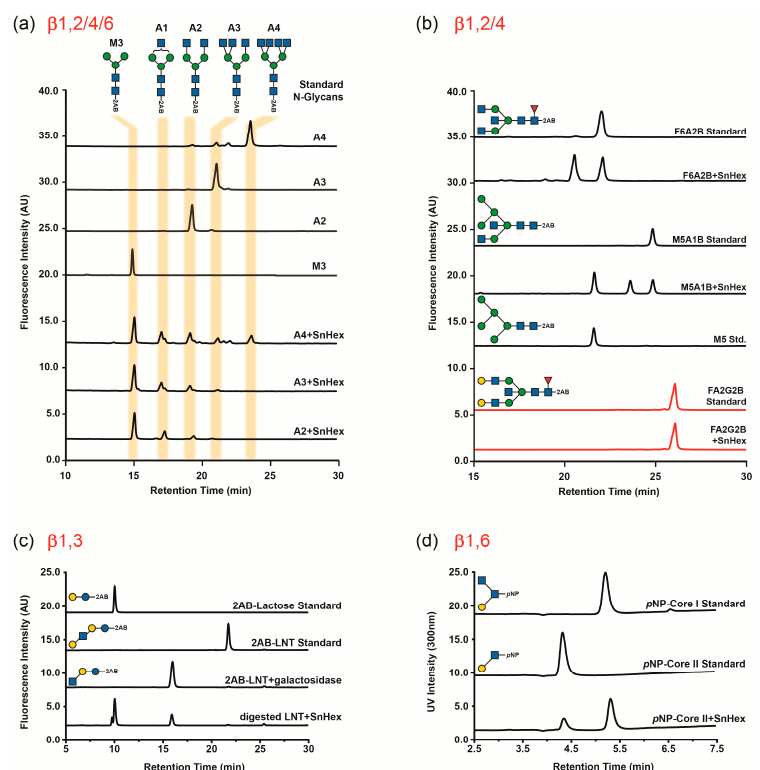
Figure 3. HPLC traces showing hydrolysis of various terminal GlcNAc residues from glycan substrates by SnHex. A detailed depiction of the glycan structures can be found in the supplementary information (Table S2).